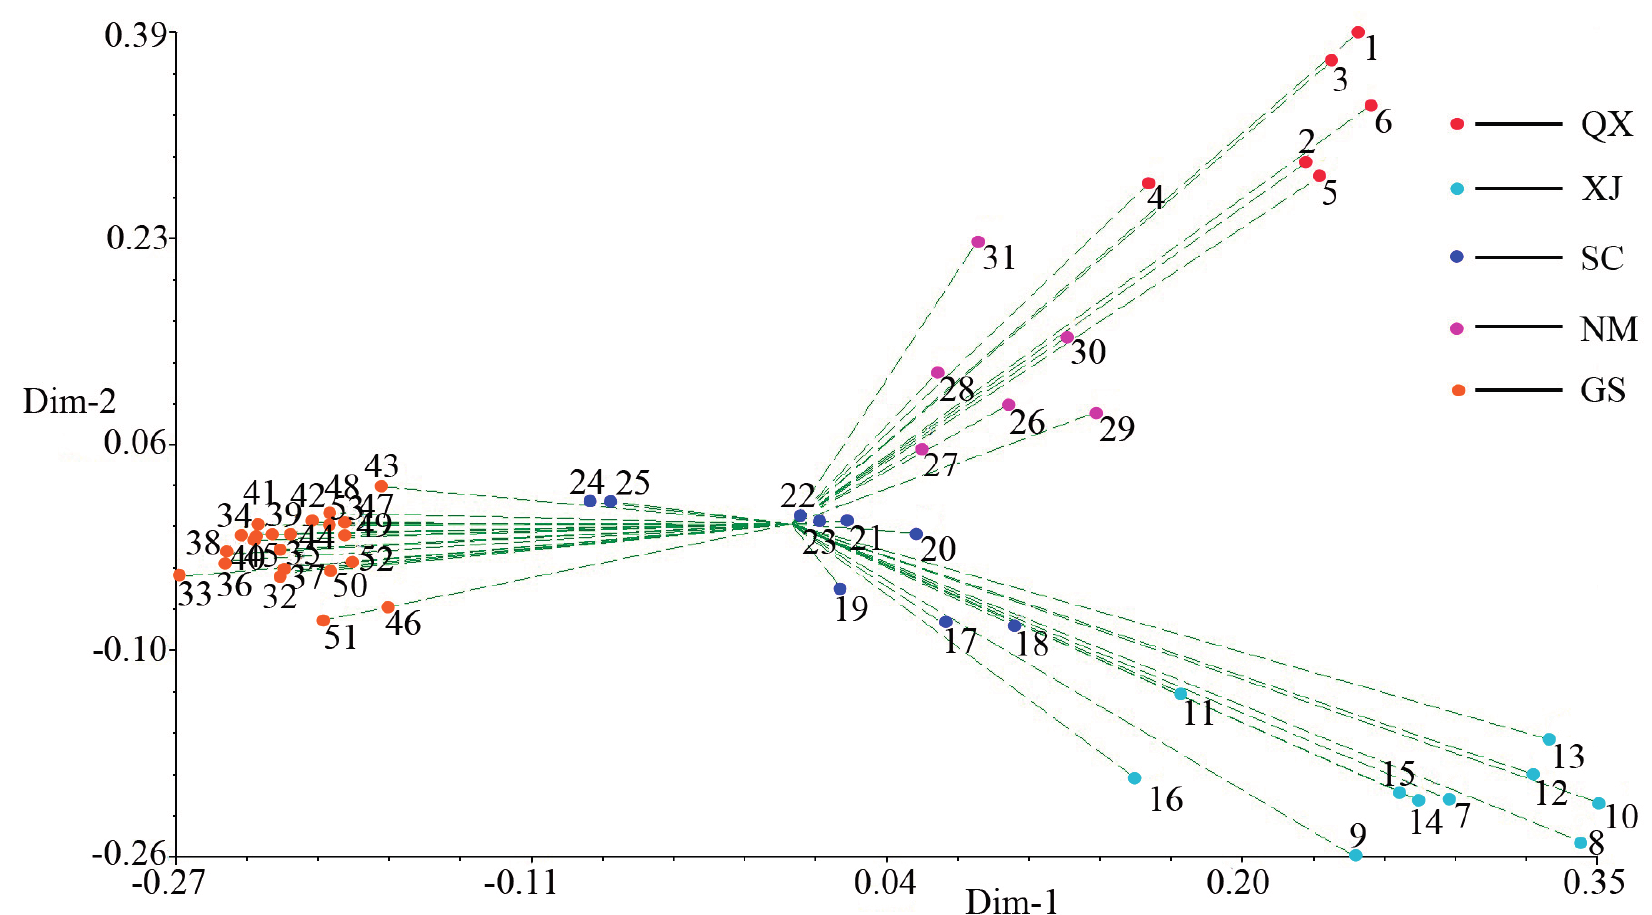
Figure 4. Principal coordinates analysis for the first and second coordinates estimated for SCoT markers using Jaccard’s genetic similarity matrix for 53 E. sibiricus